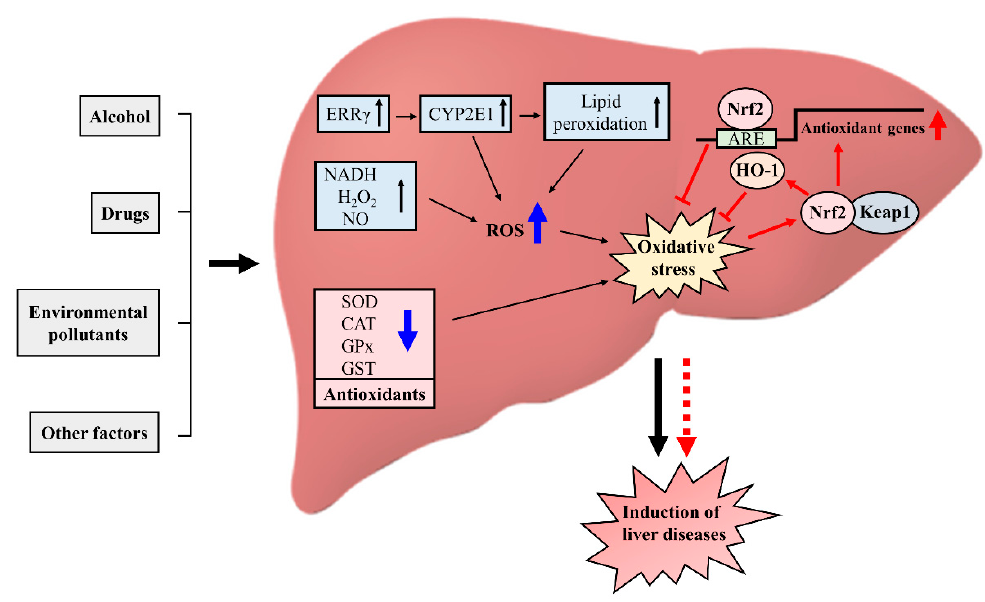
Figure 2. Various factors causing redox imbalance and oxidative stress and induction of liver dis-